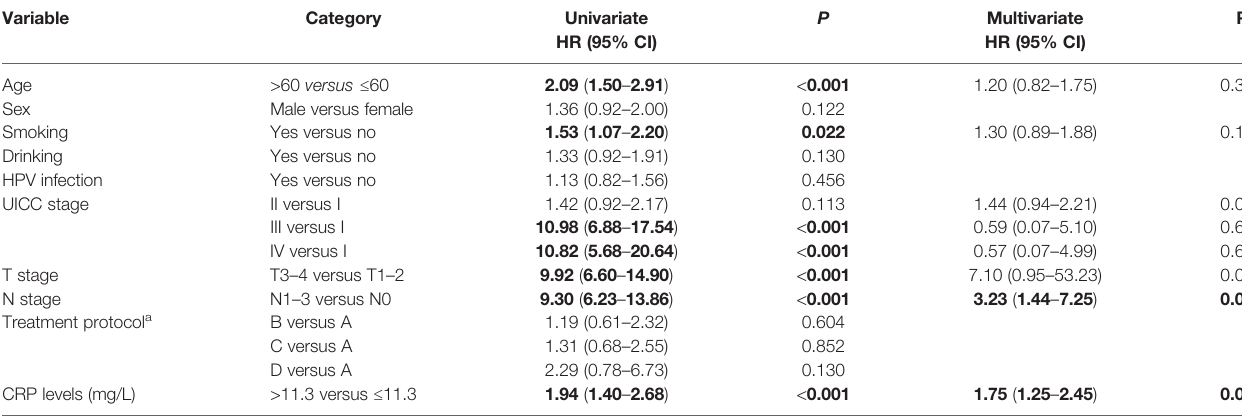
TABLE 3 | Univariate and multivariate analysis of prognostic factors affecting the progression-free survival in patients with HNSCC.